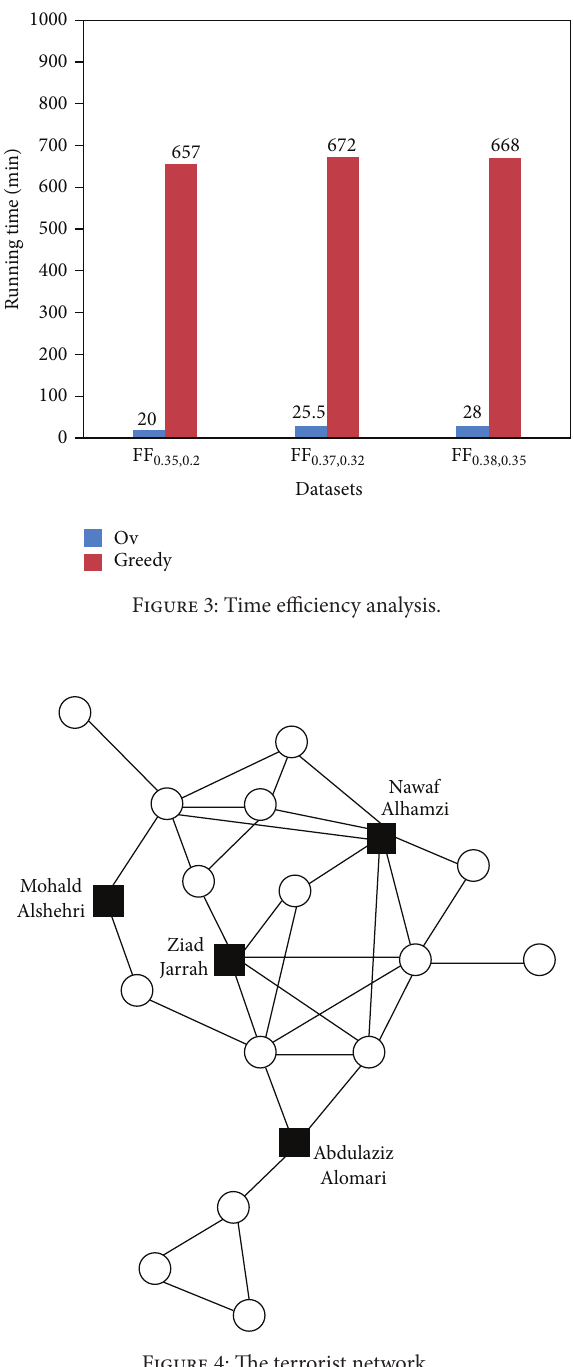
Figure 4: The terrorist